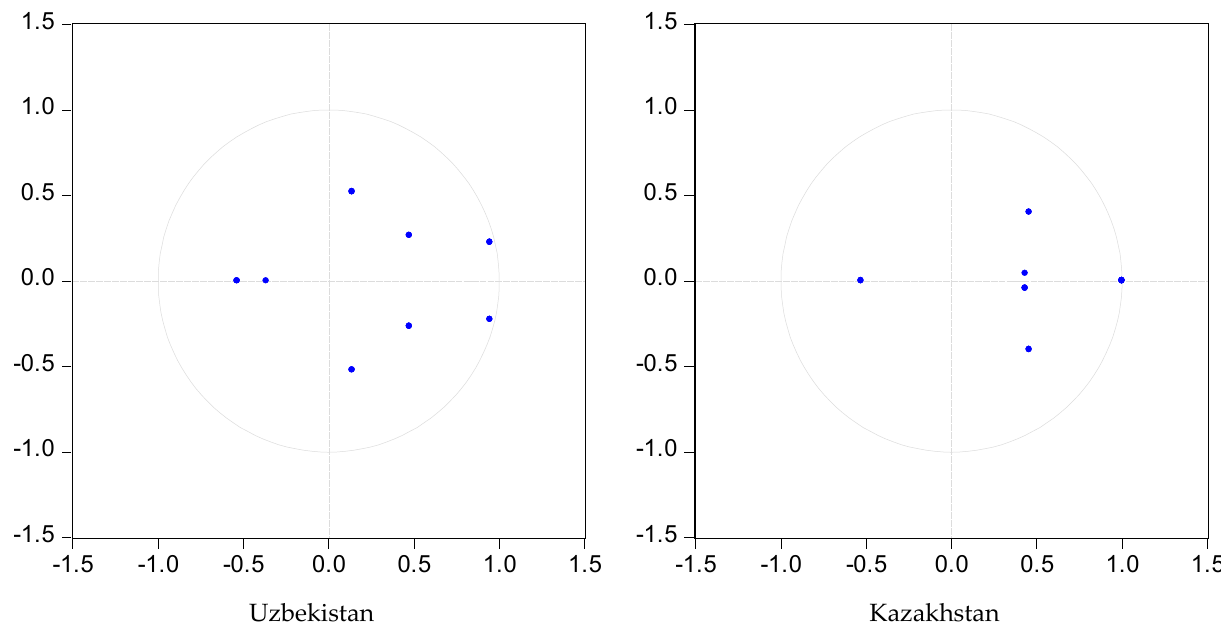
Figure 3. Graph of AR inverse root.